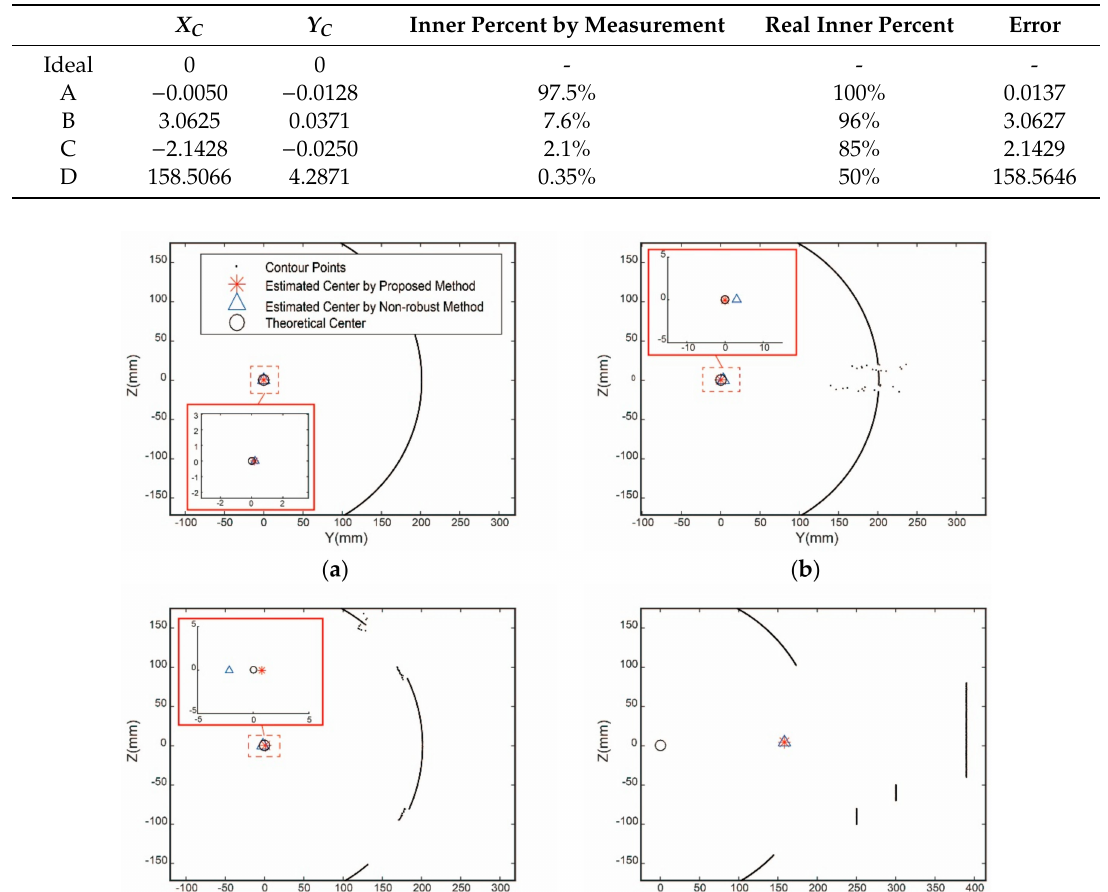
Table 1. The estimated center by general algebraic fitting (mm).